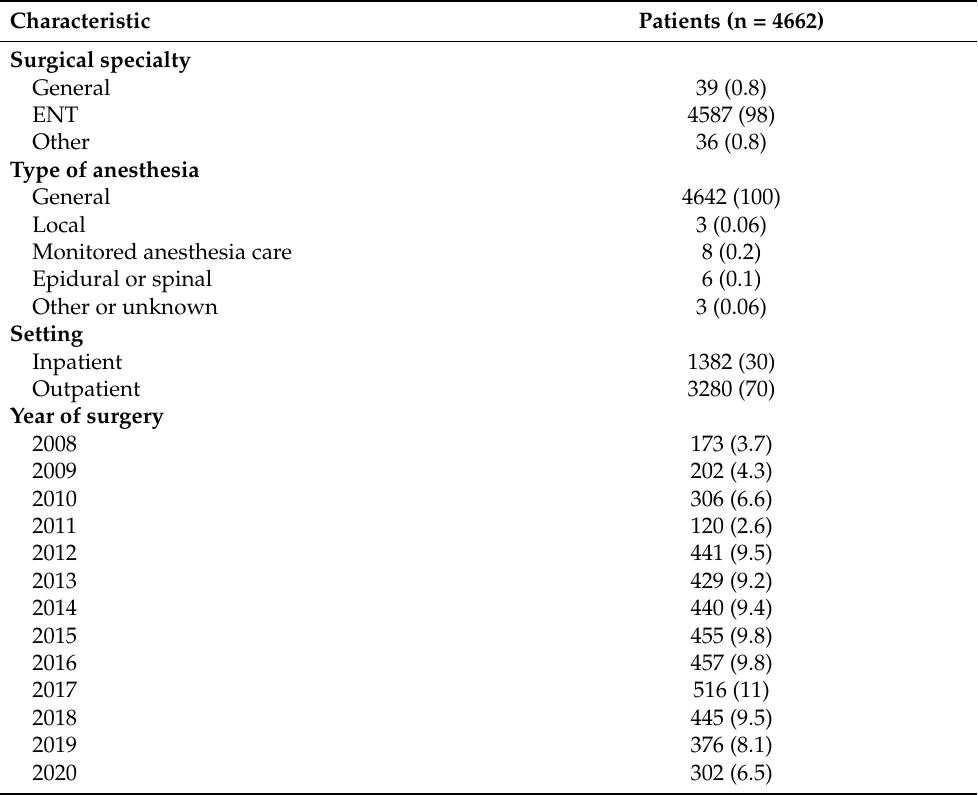
Table 2. Surgical characteristics. Reported as n (%), unless otherwise stated.